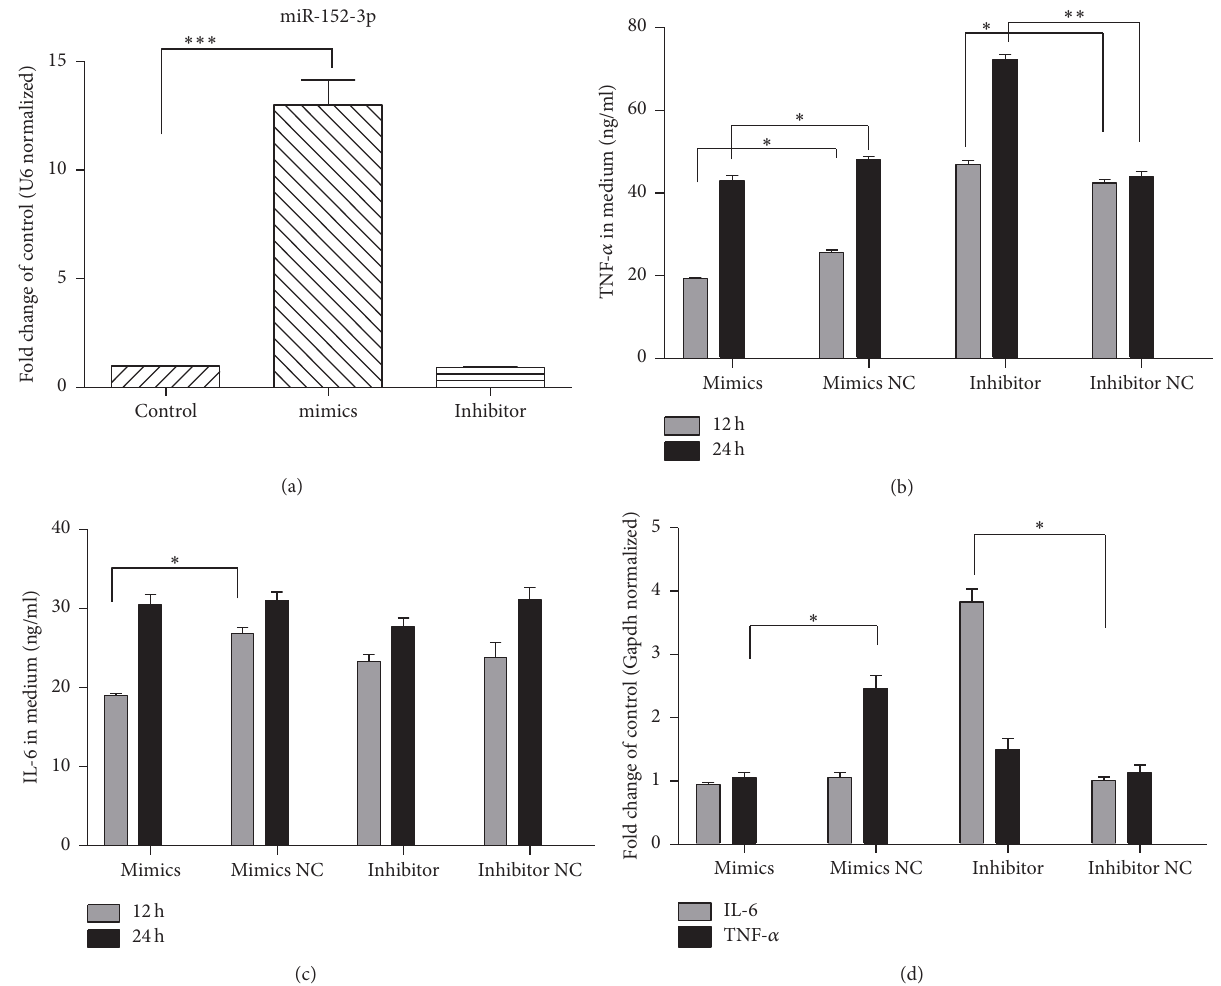
Figure 5: MiR-152-3p in Raw264.7 cells. (a) MiR-152-3p expression upon miR-152-3p mimics or inhibitors transfection. (b) TNF- 𝛼 in the medium upon miR-152-3p mimics or inhibitor pretreatment. (c) IL-6 levels in medium upon miR-152-3p mimics or inhibitor pretreatment. (d) IL-6 and TNF- 𝛼 levels mRNA expression upon miR-152-3p mimics or inhibitor pretreatment. Experiments were repeated three times for each group; ∗ 𝑃 < 0.05 , ∗∗ 𝑃 < 0.01 , and ∗∗∗ 𝑃 < 0.001 between two groups accordingly. Origin from GraphPad Prism 5.01, and data is linked.